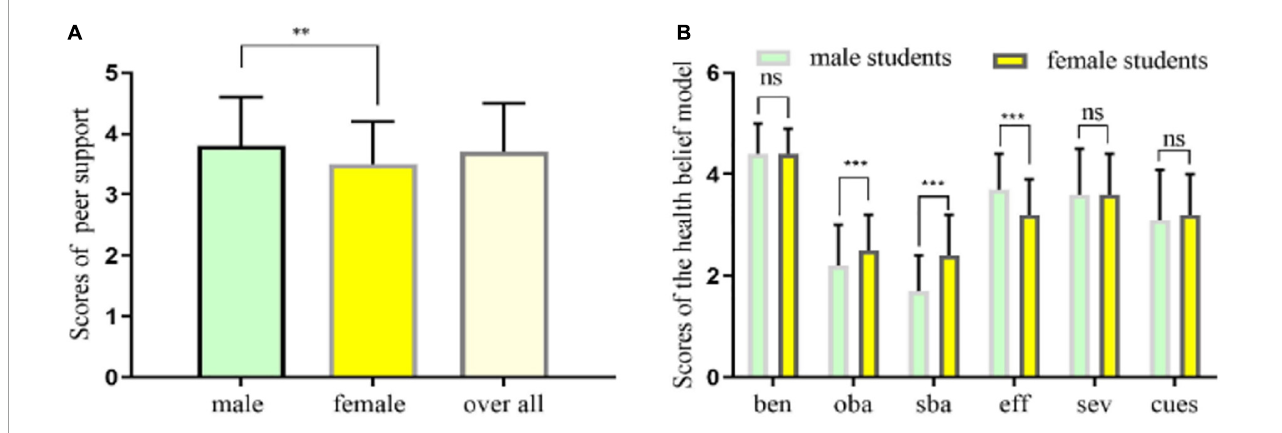
FIGURE1 (A,B) Male college students’ sup was significant higher than female, the scores of sba and oba was significant lower than female, and eff-e was significant higher than female. ben, perceived benefits; sba, perceived subjective barriers; oba, perceived objective barriers; sev, perceived severity; cues, cues to action; eff-e, exercise self-efficacy. ** p < 0.01, *** p < 0.001, ns, there was no statistical difference between two groups.